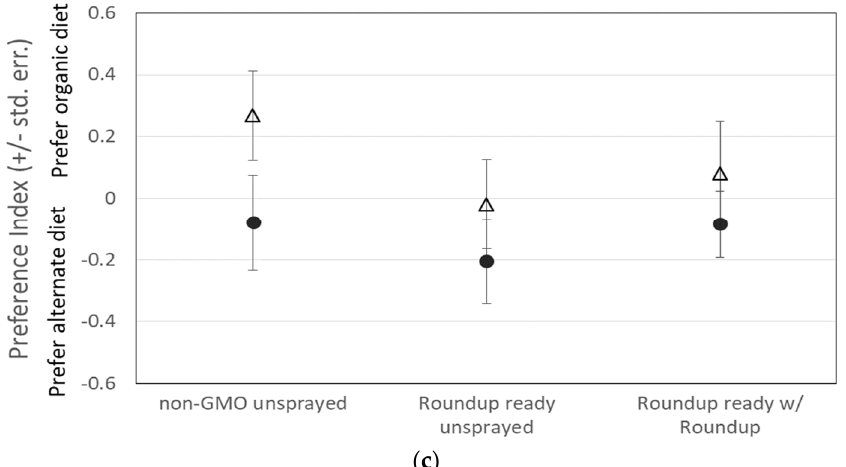
Figure 1. ( a ) The dispersal of 2874 flies for all treatments was not significantly different. Flies dispersed relatively consistently throughout all treatments. Preference for organic (+) or alternate ( − ) diet when flies were ( b ) reared on organic corn or ( c ) reared on the experimental treatment medium did not significantly differ, except that males were more likely than females to prefer the familiar diet, especially when reared on organic corn medium. λ = males, = females.